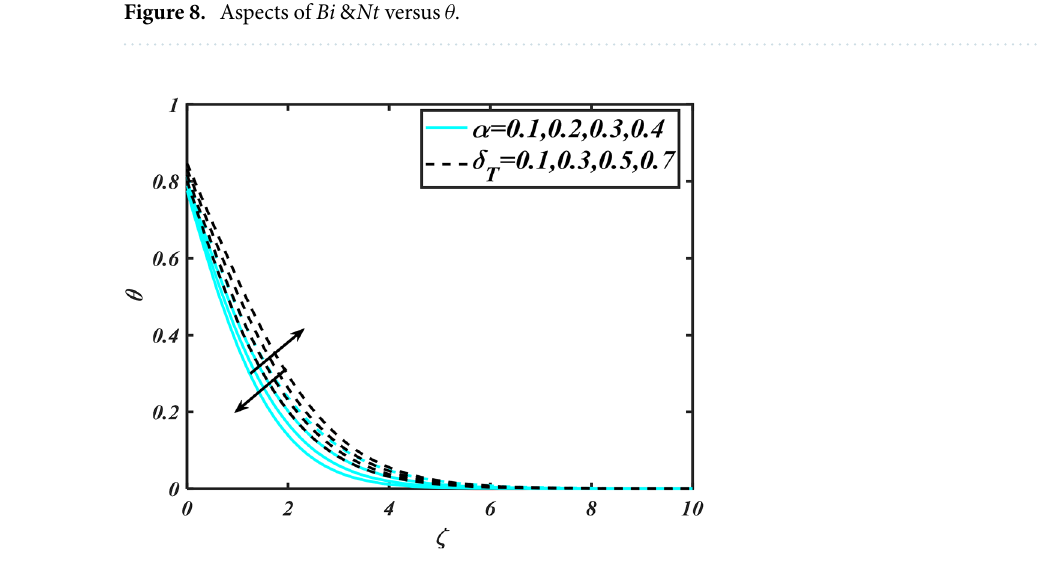
Figure 9. Aspects of α & δ T versus θ